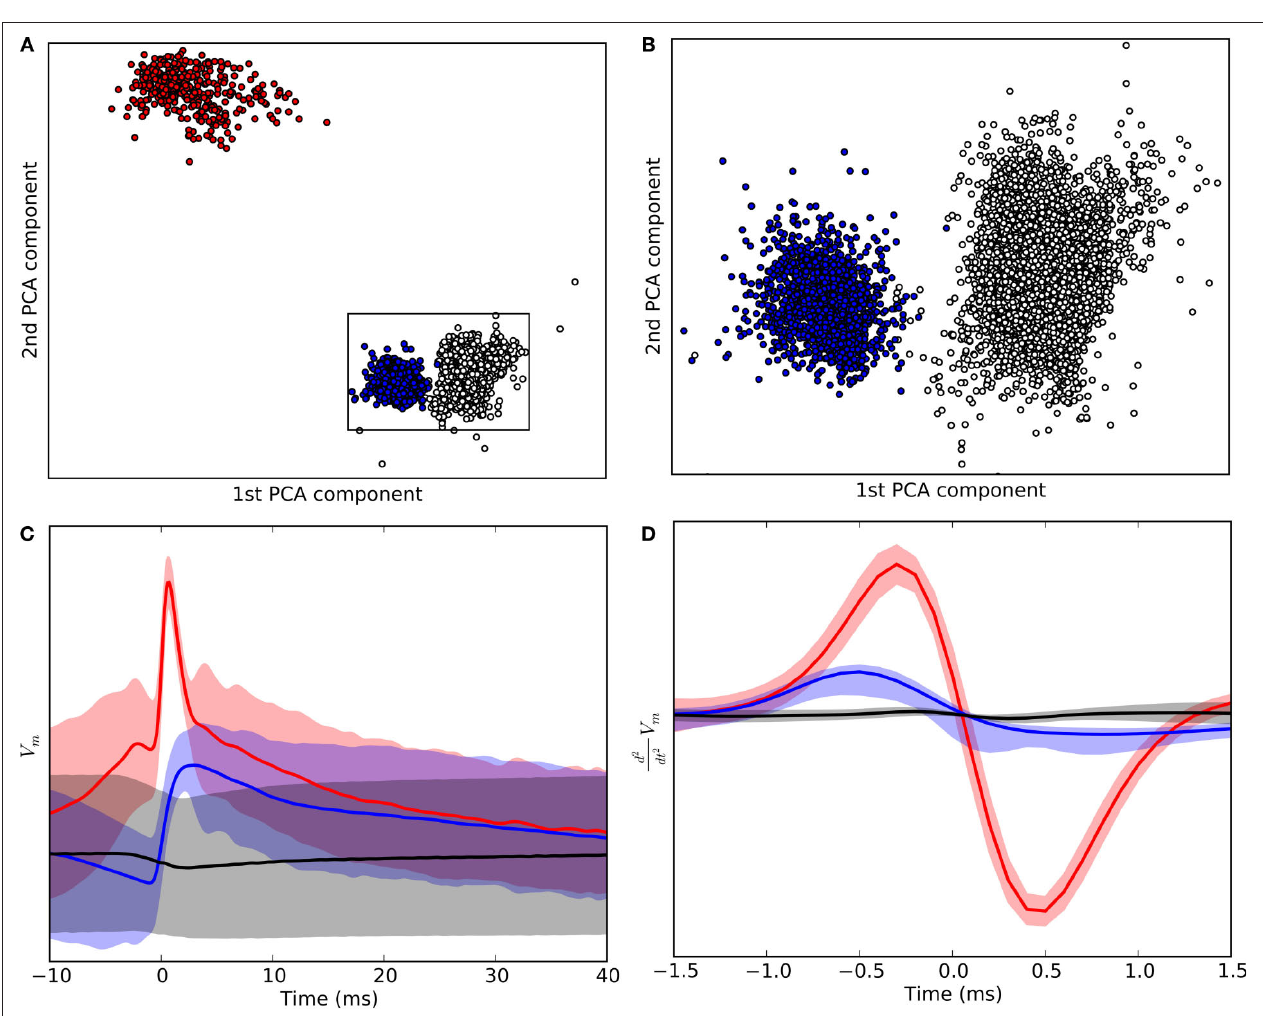
FIGURE 1 | Clustering of intracellular events. (A) Clusters of events detected in the intracellular signal. The axes of the scatter plot are the fi rst two principal components of the curvature (second derivative) of the events detected from recordings of the membrane potential. Events classifi ed as spikes are red, as EPSPs, blue, and as noise, uncolored. The rectangle marks the data range that is shown in (B) at higher magnifi cation. (B) Clusters shown in (A) at an expanded